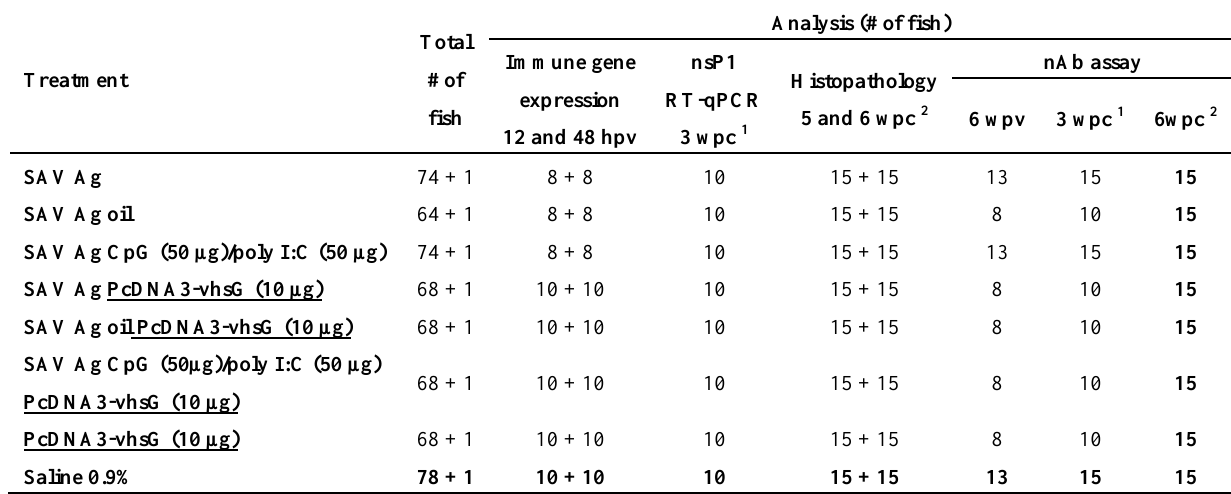
Table 1. Treatments, dose regime, number of fish and schedule for the sampling of organs and blood. Treatment